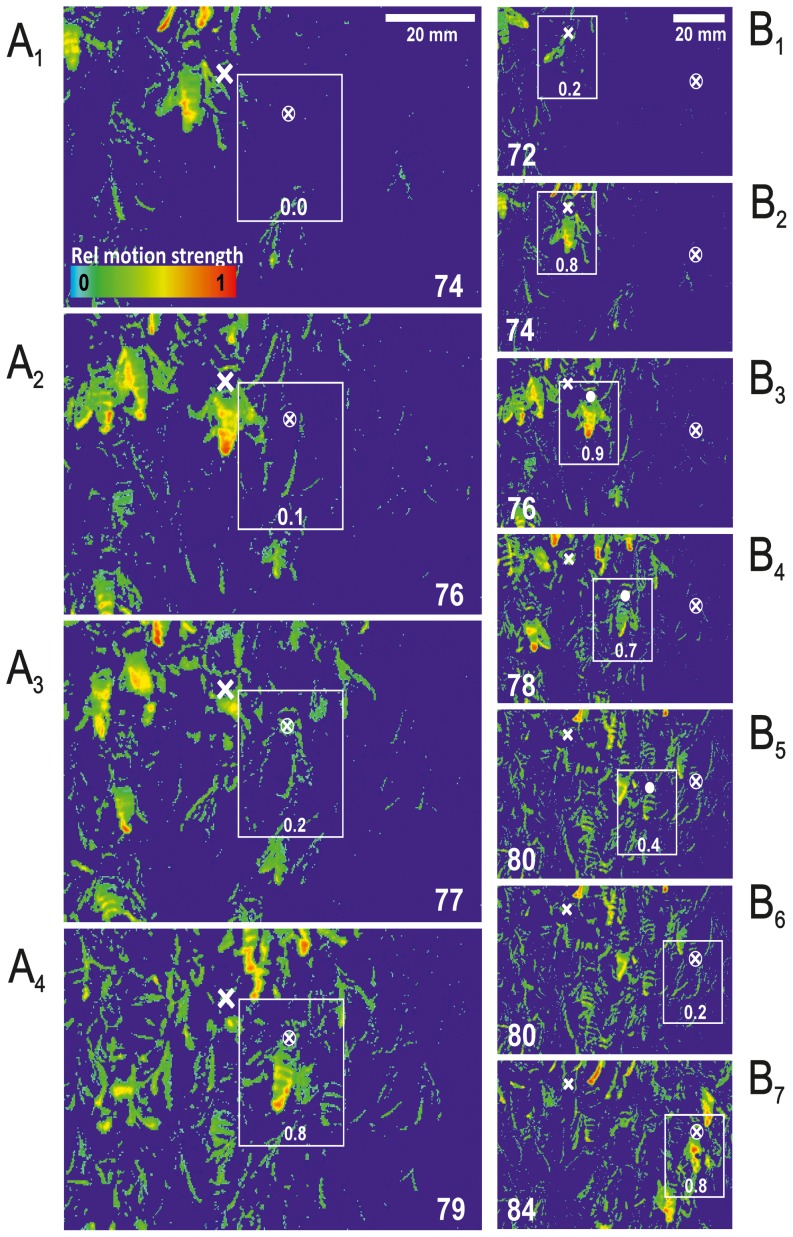
Two examples of bucket-bridging in the signal propagation of shimmering of A. dorsata.(A1–4) Information transfer from left to right () in the images, displayed over six frames (from f 74 to f 79≡100 ms) from the focus bee (whose thoracic position was marked with a white cross throughout the frames) to one of her neighbours (whose thoracic position was marked with a white cross in a white circle); differential images represent luminance [] patterns according to the rainbow scale displayed in panel A1 (see Fig. 1 and Methods), the grey open rectangles signify the extension of the receiver agent, the numbers at the bottom of the rectangles refer to the relative activation level of the shimmering incident (whereby the pixel-by-pixel luminance differences were scaled on the rainbow palette with ; for the estimation of the momentary expression of motion strength, see Equations 2a,b for retrograde and prograde extrapolation in Methods under “Benchmarking bucket-bridging”). (B1–7) Information transfer from a focus bee (thoracic position marked with a white cross) over a chain of four neighbours to a target agent; the thoracic positions of intermediate neighbours were marked by closed white circles, that of the target agent with a white cross inserted in a white circle; this target bee was passively moved from B4–B6, and flipped her abdomen in B7); the white open rectangles signify the range of the respective agent along the selected chain, the numbers inside the rectangles give the respective activation levels.